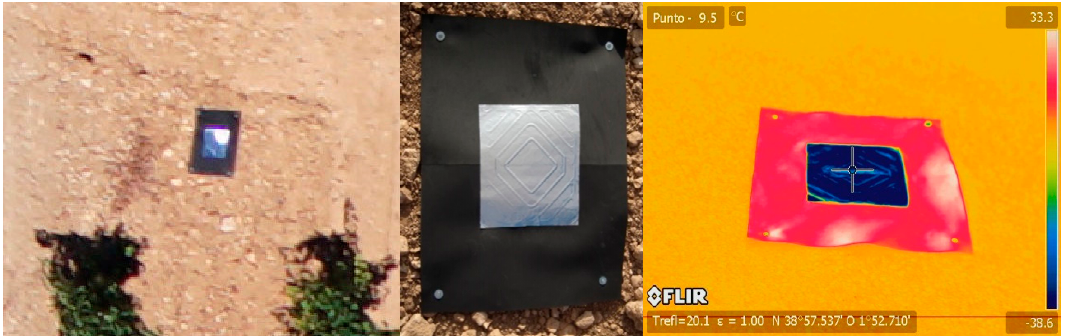
Figure 6. Type of GCPs used in thermal images.